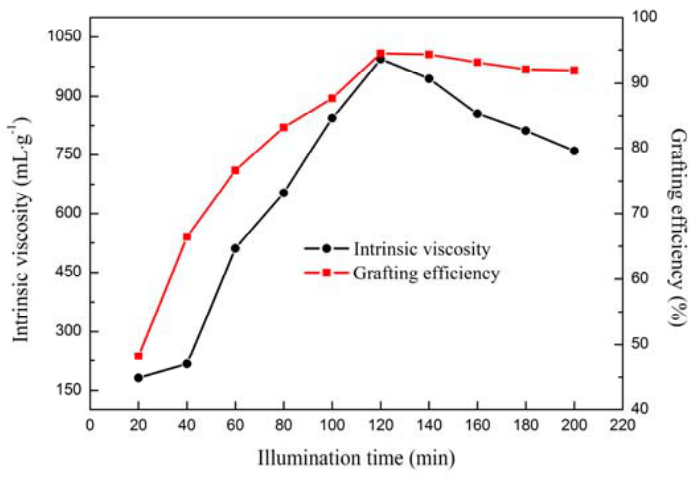
Figure 3. Effect of illumination time on intrinsic viscosity and grafting efficiency of CPCTS ‐ g ‐ P (CTA ‐ DMDAAC).